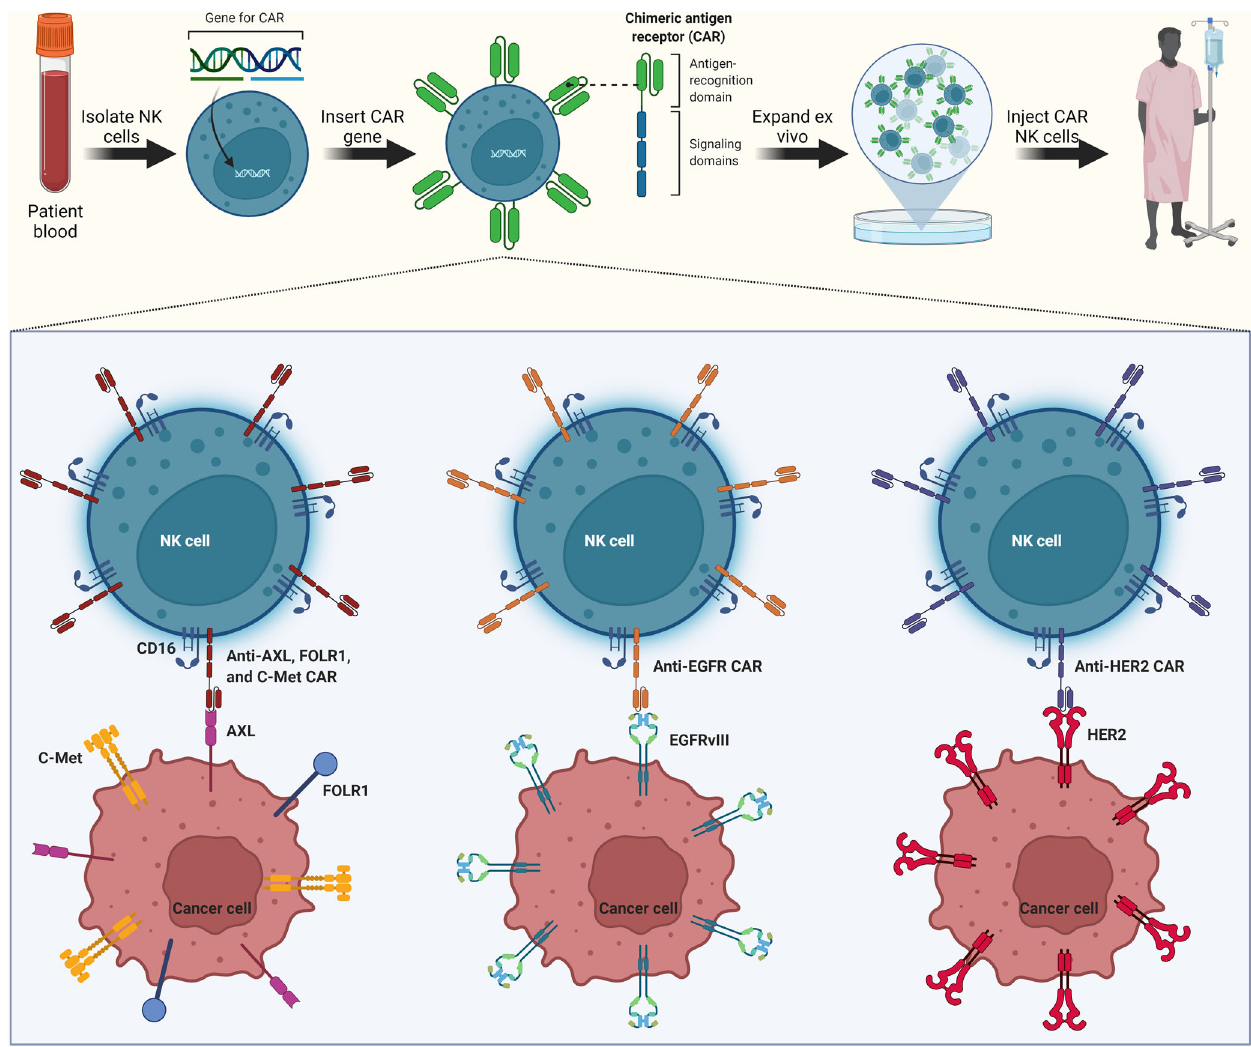
Fig. 4 Adoptive CAR NK cell therapeutics in brain tumors. Chimeric antigen receptor (CAR) approaches utilize primary NK cells (isolated from patients) or NK cell lines and their transduction with a CAR gene to produce CARs. CARs consist of an antigen-recognition domain and signaling domain that utilizes down-stream signaling adapters such as the CD16 molecule. Following expansion of the CAR NK cells ex vivo, the cells are injected back into patients with brain tumors. In vitro, CAR KHYG-1 NK cells have been used to target c-Met, FOLR1, and AXL receptors that are overexpressed in glioblastoma cell lines. In preclinical settings, anti-EGFR/EGFRvIII and anti-HER2 CAR-NK cells have also demonstrated enhanced cytotoxicity against glioblastoma cells in vitro and resulted in increased tumor control and survival in animal models. Anti-EGFR CAR NK cells further showed lytic effects in combination with oncolytic virotherapy in metastatic brain